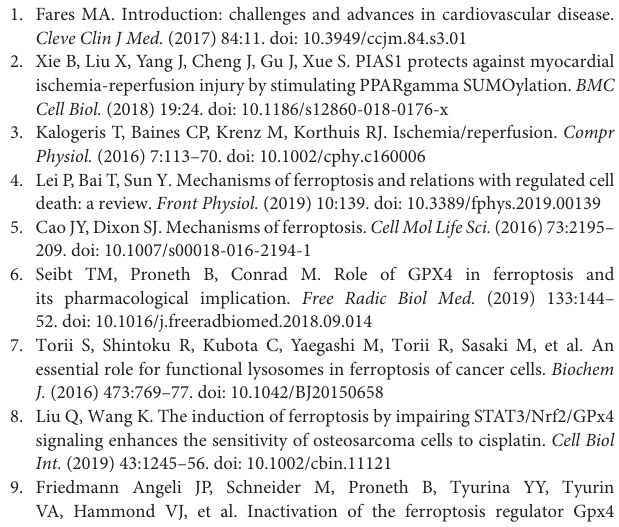
Supplementary Table 1 | The ARRIVE guidelines 2.0 author checklist. Supplementary Table 2 | The primer sequences of genes in RT-qPCR assay.